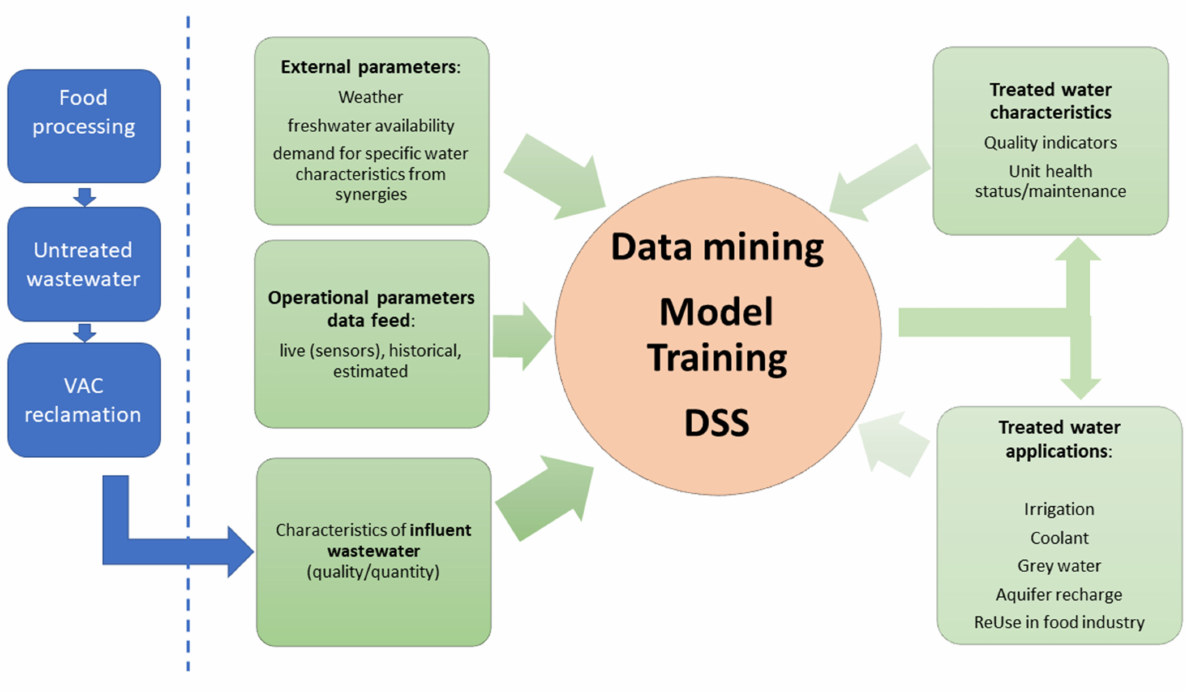
Figure 2. Flow chart of the proposed